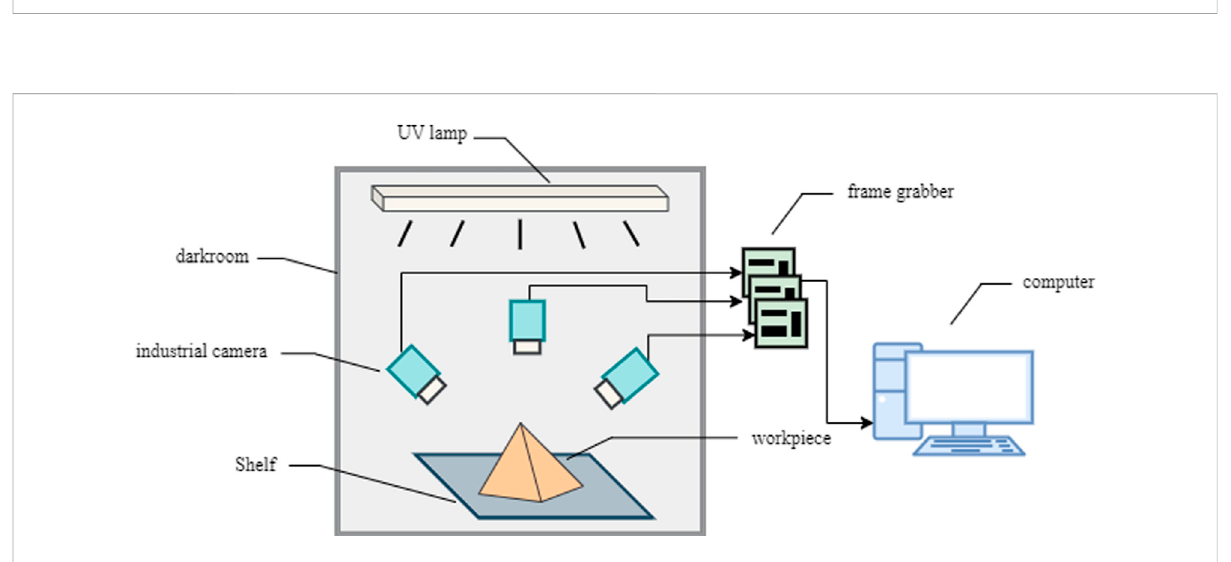
FIGURE 2 Grayscale distribution of crack and interference images (A) Grayscale distribution of dust residue (B) Grayscale distribution of ultraviolet light re fl ection (C) Grayscale distribution of edge disturbance (D) Grayscale distribution of permeate residue (E) Grayscale distribution of crack.